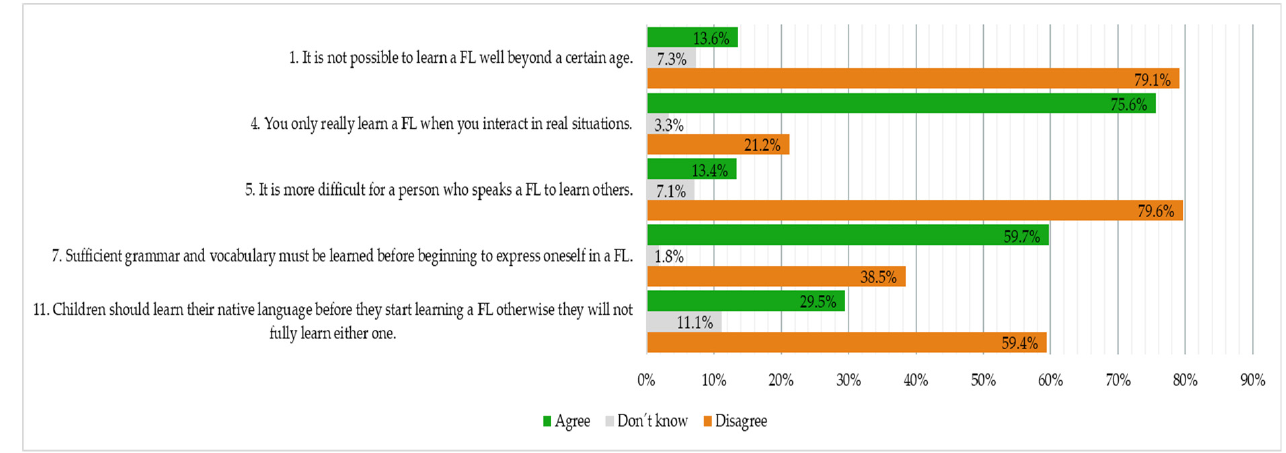
Figure 3. Frequency distribution of the 5 items that make up Dimension 3. Language learning.